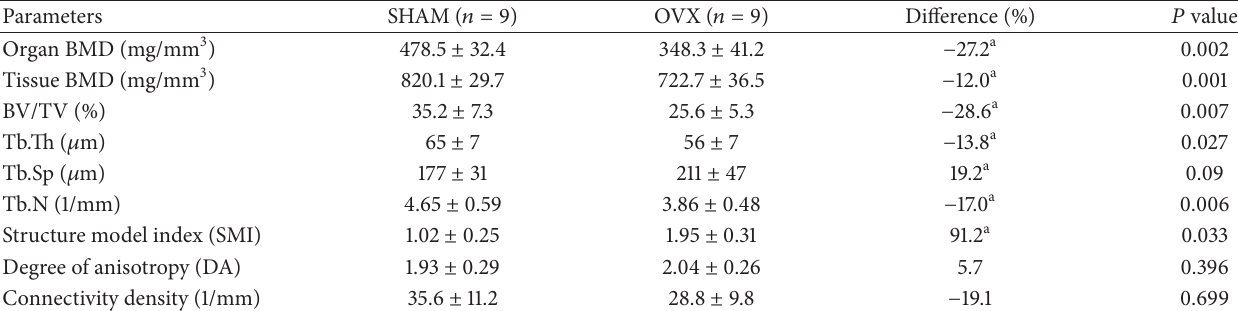
Table 2: Trabecular volumetric BMD at organ and tissue levels and 3D microstructure evaluated by